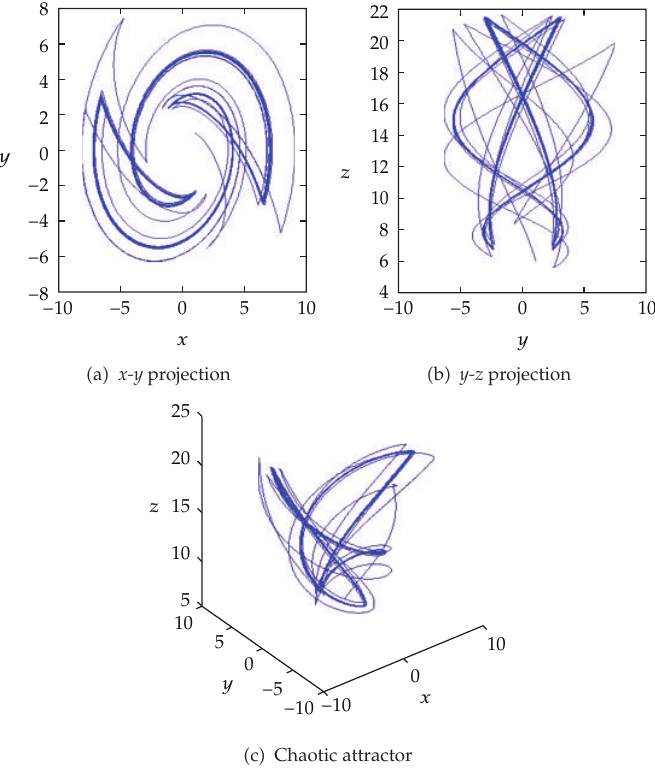
Figure 6: Chaotic attractor generated by F 1 (cid:7) 6, F 2 (cid:7)